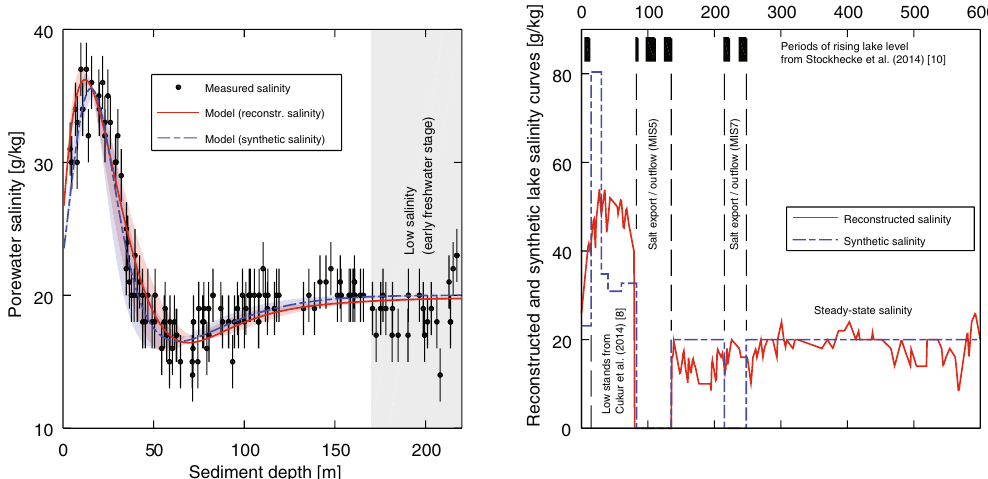
Figure 2. Salinity profile measured in the pore water of Lake Van. The porewater salinity was measured in core-catcher samples during ICDP PaleoVan drilling operations in 2010 (left-hand panel, black dots). The area shaded gray marks the depth range characterized by lower salinities that might correspond to past freshwater stages of Lake Van 15, 23 . Modeling the physical transport of salt through the sediment pore space (left-hand panel, red line and dashed blue line) shows that the salinity changes in the uppermost 100 m can be reproduced reasonably well either using the reconstructed (right-hand panel, red line) or synthetic (right-hand panel, dashed blue line) salinity curve as a temporal boundary condition at the sediment/water interface. The areas shaded red and blue in the left-hand panel represent the variation range of the model results depending on the molecular diffusivities of the various ions contributing to the overall salinity. Between 83 and 135 ka BP (MIS5), and between 215 and 248 ka BP (MIS7), the synthetic input curve implies the export of salt from Lake Van through an